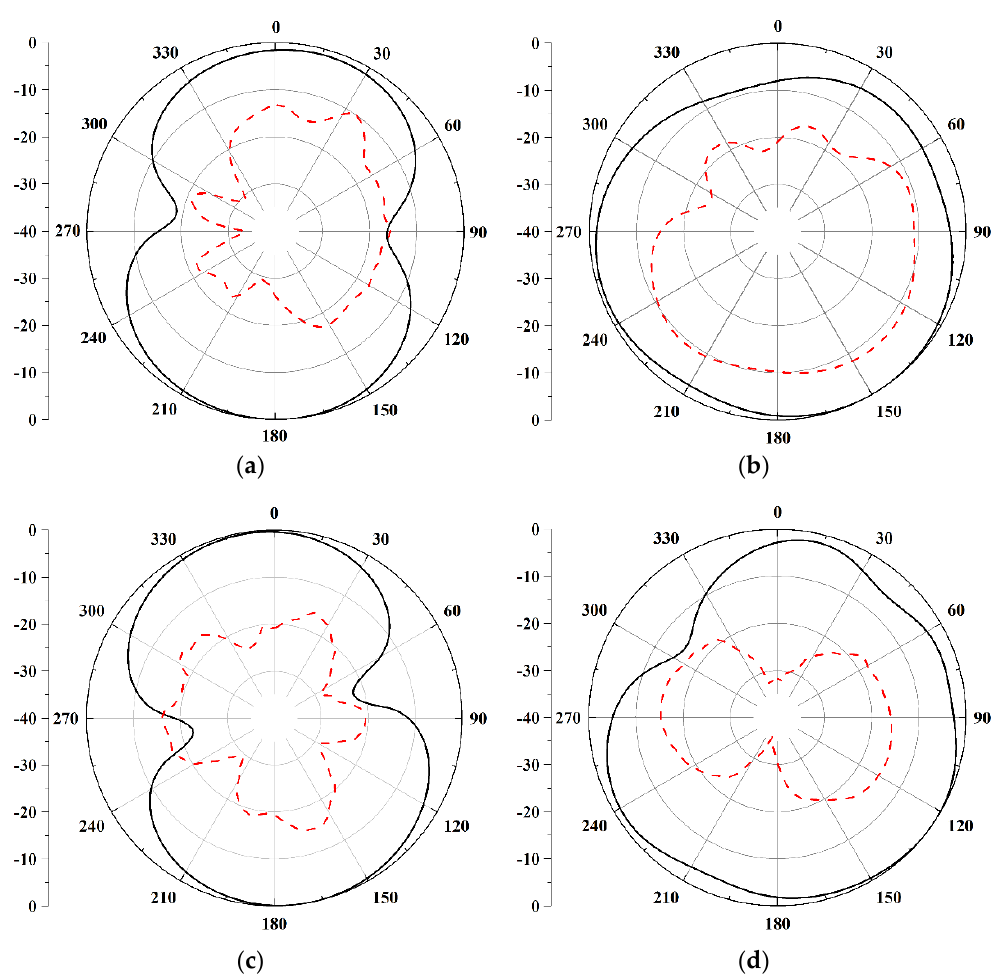
Figure 9. Measured peak gain and radiation efficiency.